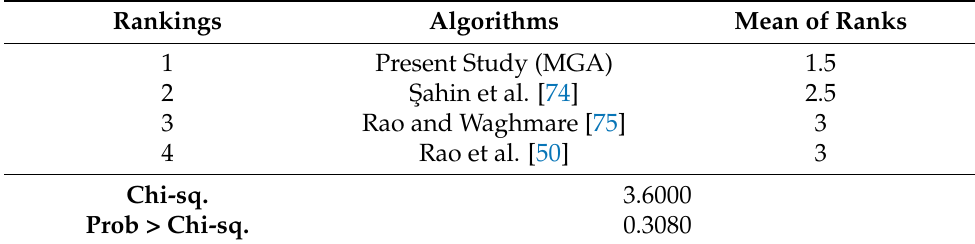
Table 18. Friedman statistical test results for the hydrostatic thrust bearing design problem.